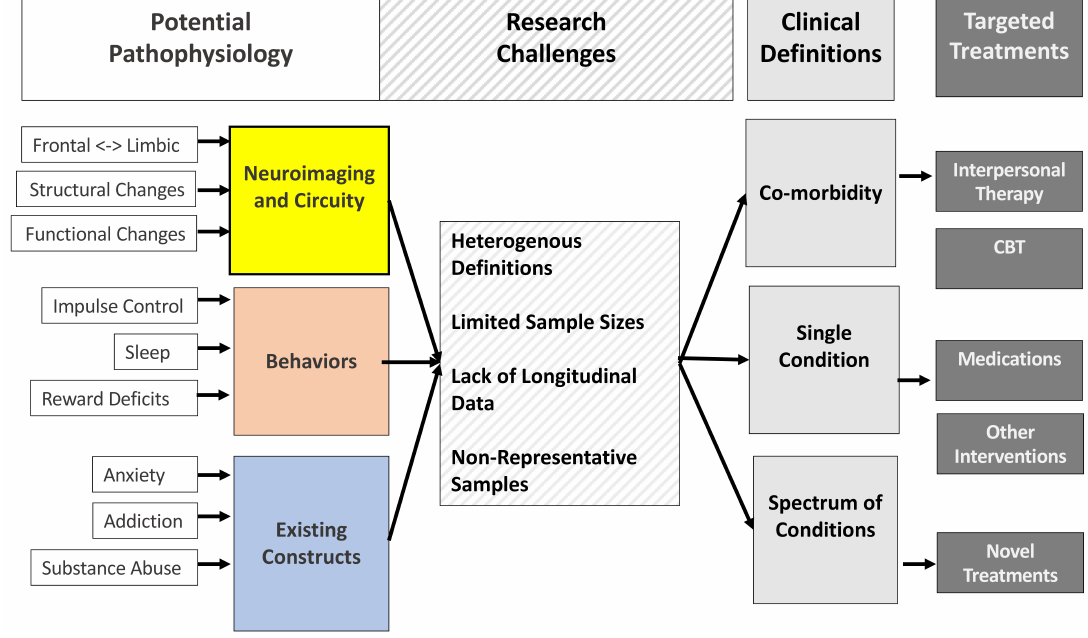
Figure 1. Synthesis of potential underpinning processes, risk factors, and treatments of internet usage disorders, along with contemporary challenges faced by current research within this